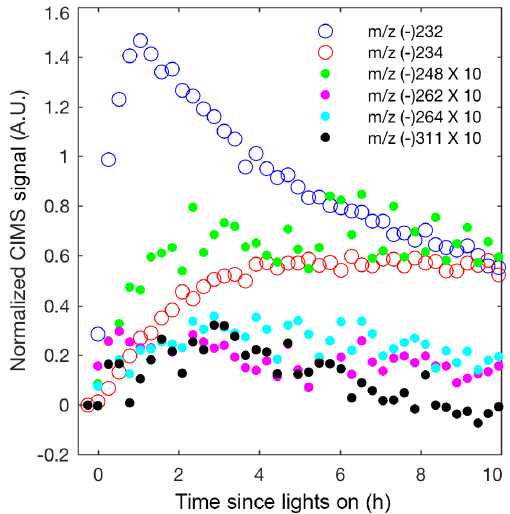
Figure 8. Normalized CIMS signal for known nitrates: C 5 hy- droxy nitrate ( m/z (–) 232; blue circle), methyl vinyl ketone or methacrolein nitrate ( m/z (–) 234; red circle), and C 5 dihydroxy dinitrate ( m/z (–) 311; black filled circle) and unknown nitrates, which are postulated in Fig. 1 as C 5 dihydroxy nitrate ( m/z (–) 248; green filled circle), unknown ( m/z (–) 262; magenta filled circle), and C 5 dihydroxy carbonyl nitrate ( m/z (–) 264; cyan filled circle). As indicated in the legend, signals represented by filled circles are multiplied by